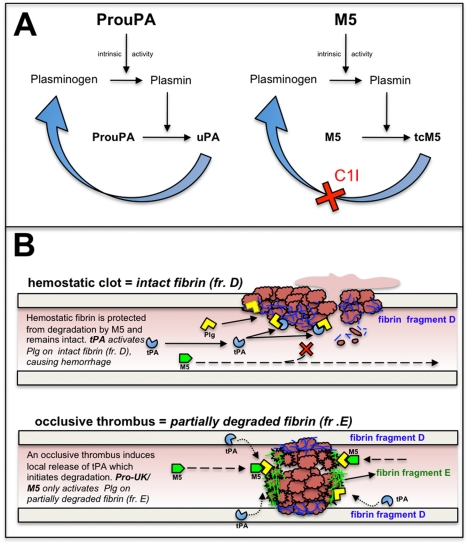
Illustration of ProuPA vs M5 at therapeutic concentrations in plasma and of the lysis of hemostatic vs occlusive fibrin by tPA and M5.A. At therapeutic concentrations of prouPA or M5, their intrinsic activities can activate plasminogen in plasma and the plasmin generated will then activate these proenzymes to their respective enzymes uPA and tcM5. The latter is irreversibly inactivated by C1I, which prevents the positive feedback, thereby preventing non-specific plasmin generation responsible for hemorrhagic side effects. B. Hemostatic fibrin, being protected from degradation physiologically, contains only the plasminogen binding site on the fibrin fragment-D domain of intact fibrin. At therapeutic concentrations, tPA, being free of its inhibitor PAI-1, will bind to an adjacent site to plasminogen resulting in its activation and bleeding from the degraded hemostatic site. Occlusive thrombus triggers the release of tPA from the vessel wall which initiates its degradation physiologically. This exposes new plasminogen binding site, particularly the high affinity site on fibrin fragment E domain with its three C-terminal lysine. Plasminogen binding to this site undergoes a conformational shape change which permits its activation by M5 causing lysis. TPA will also lyse the occlusive clot since other plasminogen binding sites remain. The two plasminogen activators are complementary and synergistic in their fibrinolytic mechanisms.